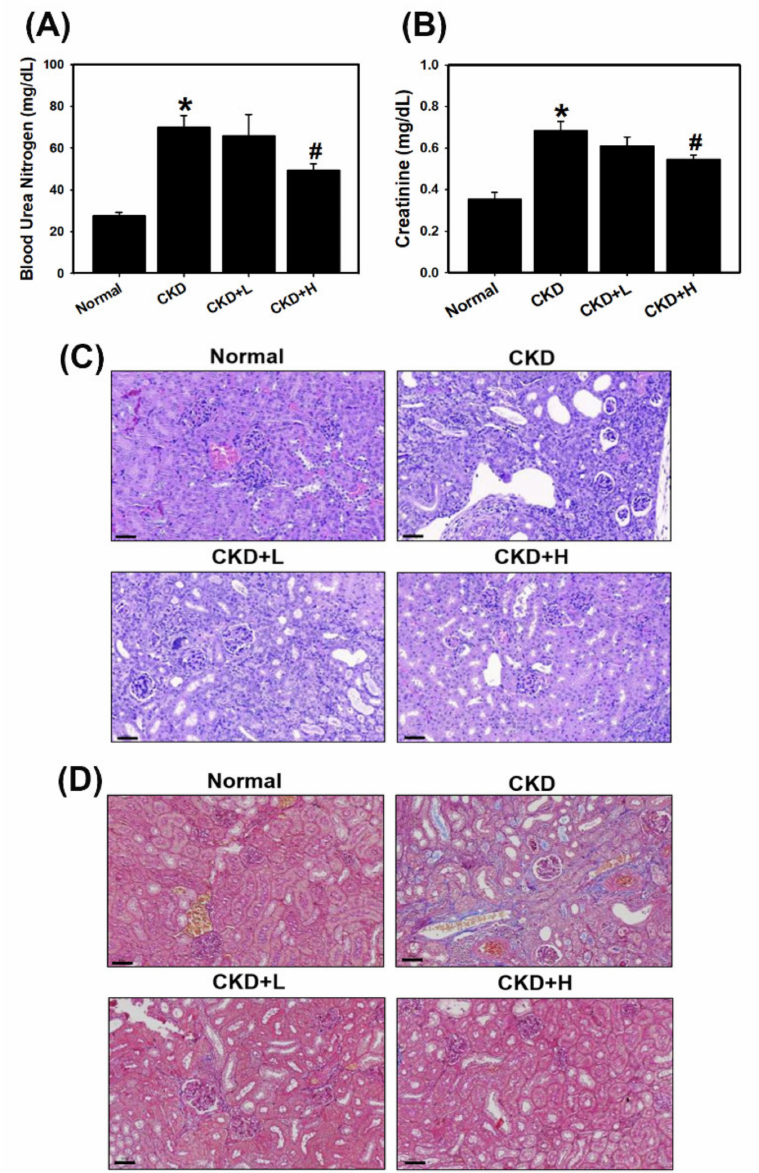
Figure 5. Biochemical and histopathological analyses of a mouse model of adenine diet-induced CKD. Renal function was evaluated by analyzing blood urea nitrogen (BUN) ( A ) and creatinine ( B ) levels (five mice per group). * p < 0.05 compared with the normal group. # p < 0.05 compared with the CKD group. Data are presented as the means ± standard deviation. Representative micrographs of H&E ( C ) and Masson’s trichrome ( D ) staining in the indicated groups in the adenine diet-induced CKD model. Scale bar = 60 µ